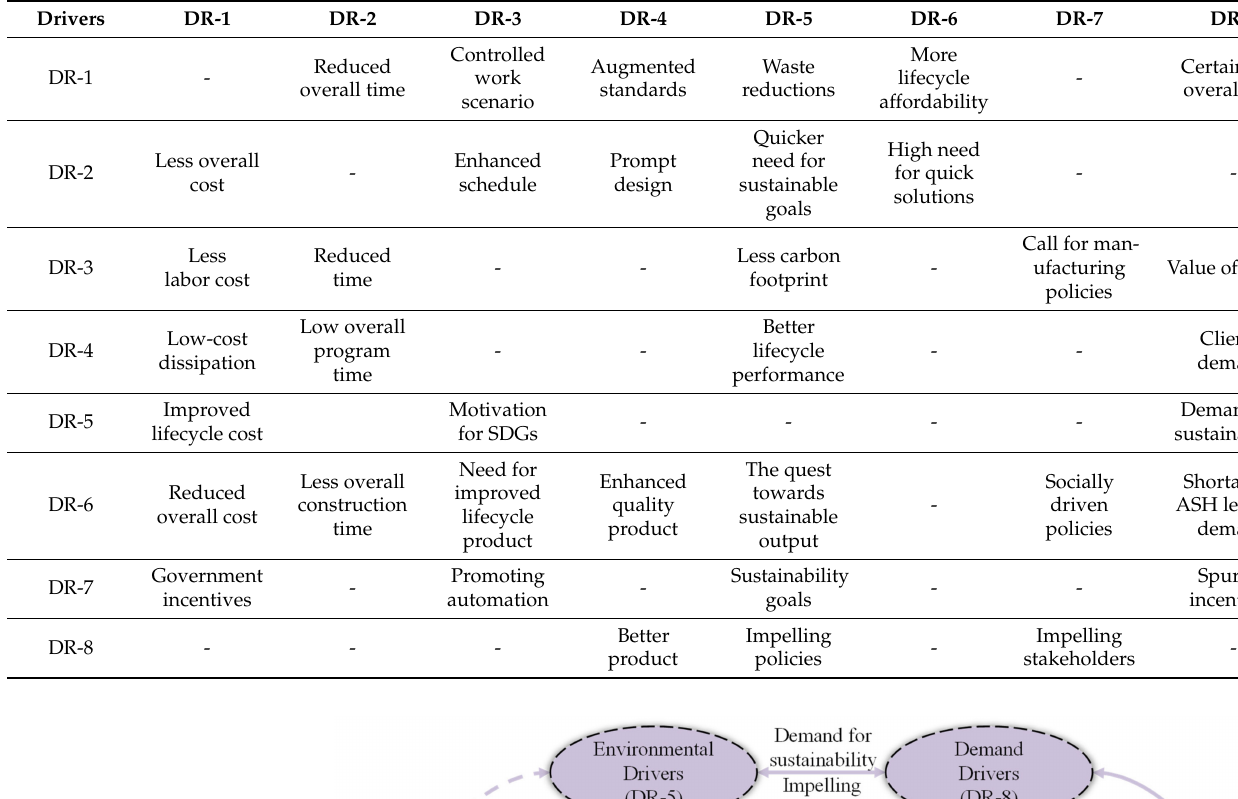
Table 4. Drivers’ transitive links with each other based on TISM.